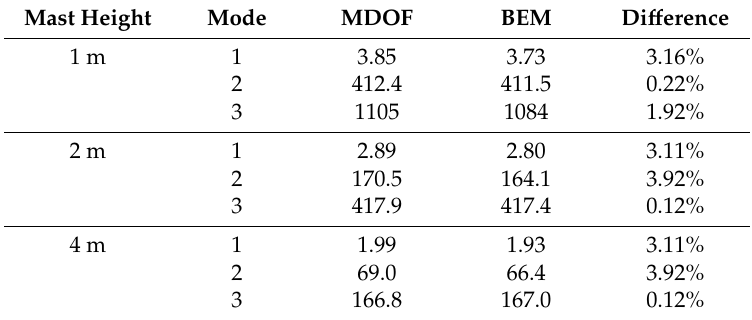
Table 9. First three natural frequencies of the MDOF model and BEM of the hybrid VAWT with different mast heights.